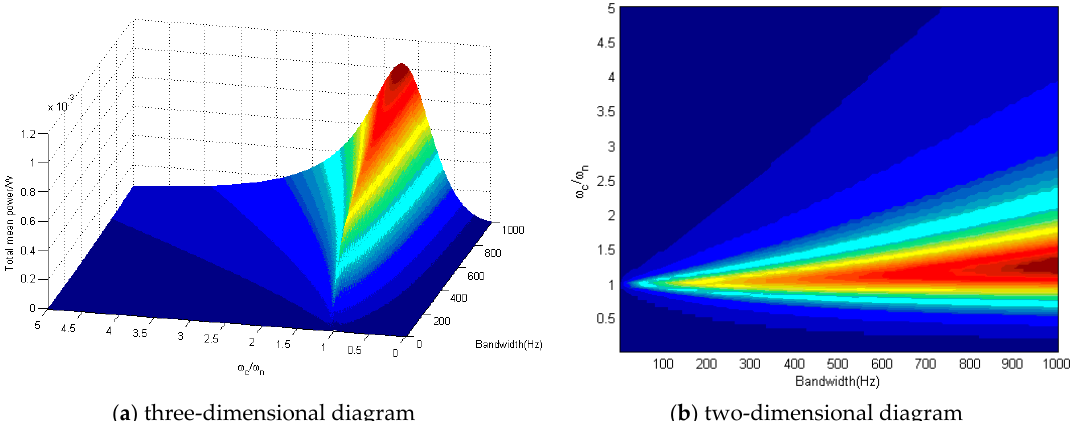
Figure 7. Total mean power of linear hybrid energy harvester with different excitation bandwidths and center frequencies.